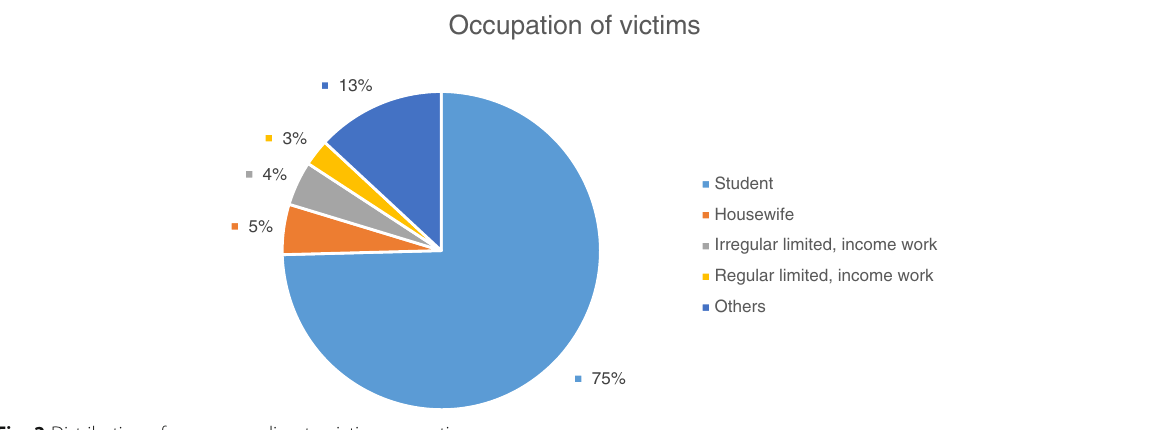
Fig. 2 Distribution of cases according to victim occupation